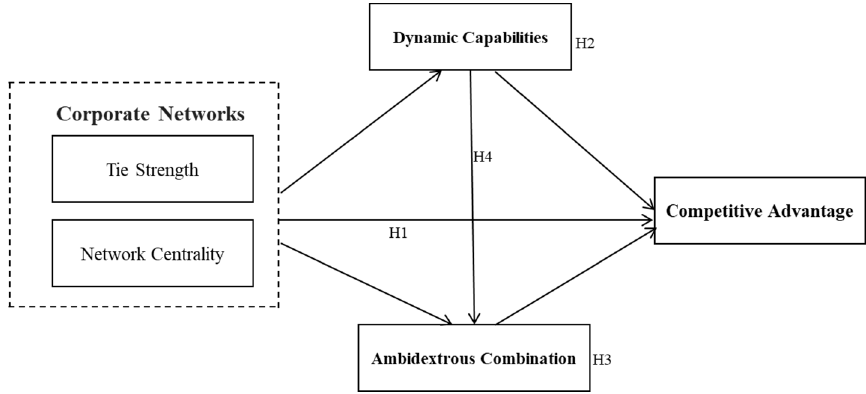
Figure 1. The conceptual